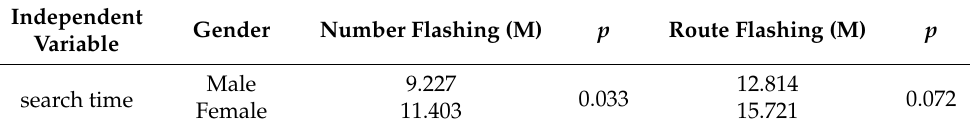
Table 4. Search Time of Different Real-Time Information.